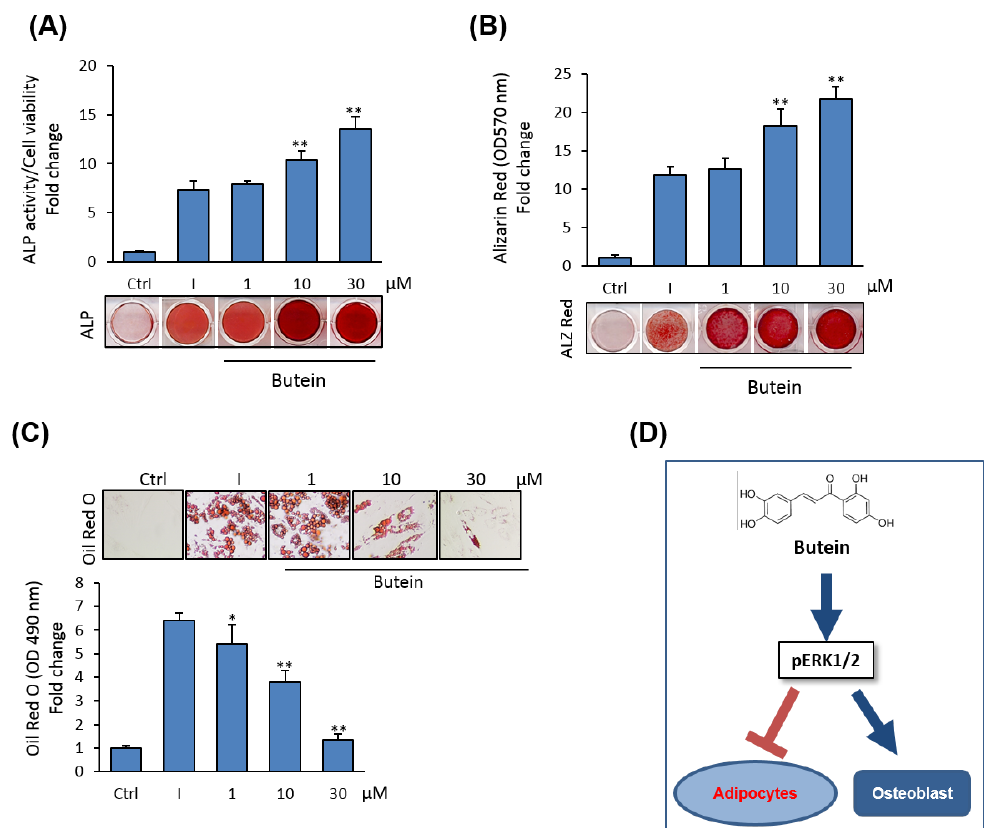
Figure 6. Butein stimulates osteogenesis and inhibits adipogenesis in human (h) BMSCs. ( A ) Dose- dependent stimulatory effect of butein on osteoblast differentiation of hBMSCs as measured by quantification of ALP activity and ( B ) quantification using Alizarin Red staining for matrix mineralization. Images for staining were presented. ( C ) Dose-dependent inhibitory effect of butein on adipocyte differentiation of hBMSCs as assessed by Oil Red O staining quantification. Staining images were presented. ( D ) Schematic diagram demonstrates the stimulatory effect (arrow) of butein on osteogenesis and the inhibitory effect (blunted arrow) of butein on adipogenesis of BMSCs via activating ERK1/2 signaling. Values are mean ± SD of three independent experiments, (* p < 0.05, ** p < 0.005 compared to differentiated cells without butein).